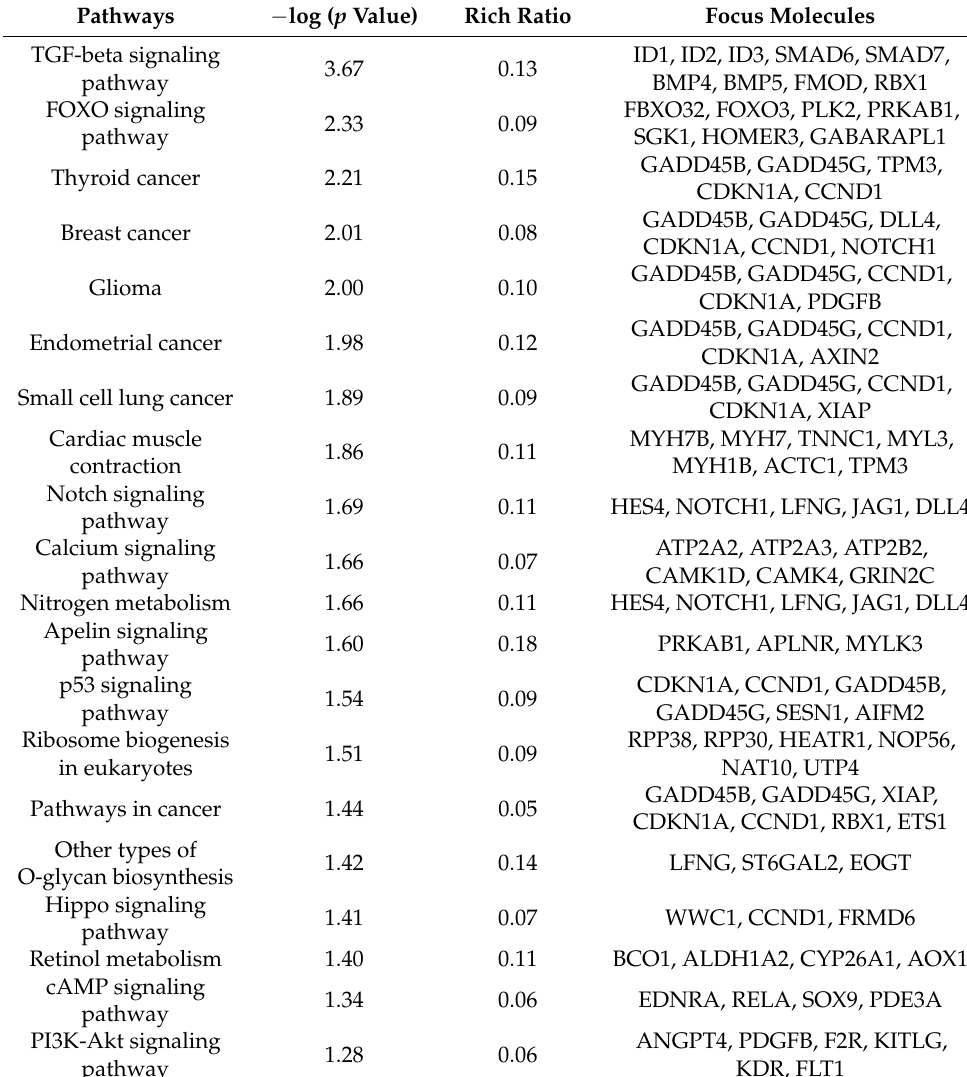
Table 2. Top 20 enriched KEGG pathways ( p <